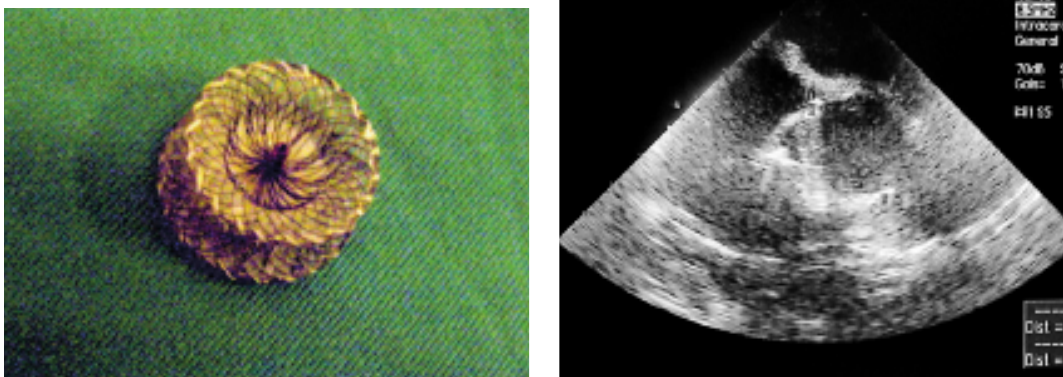
Front view of 12 mm Amplatz occluder. It is made of a nickel – titanium alloy with a pre determined thermal memory shape, which allows the device to be crimped into the deliv- ery sheath. The device is mounted into a 30 F sheath to sim- ulate the deployment of a 25 mm stented valve and its inser- tion is aided by a semi rigid wire.